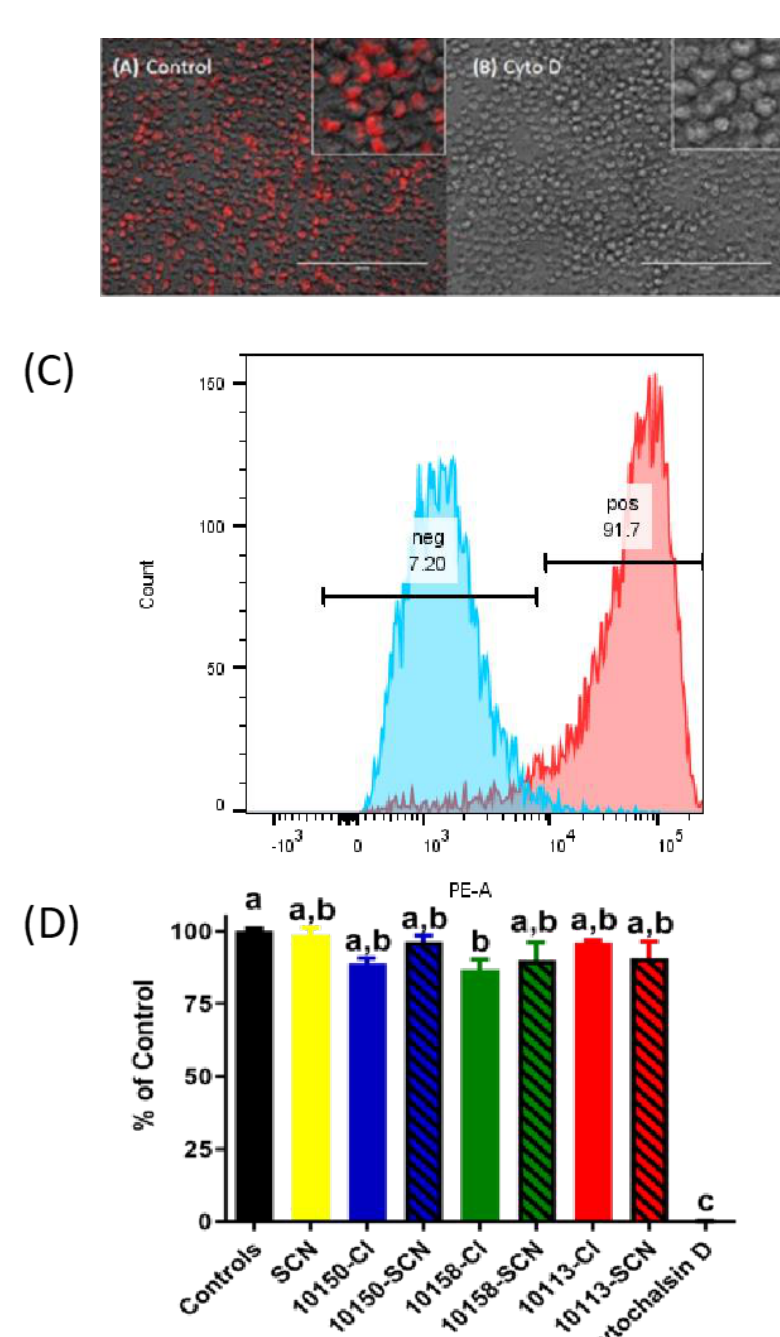
Figure 9. Meso -porphyrin formulation does not interfere with phagocytosis . Mouse macrophage cells (J774A.1) were treated for 1 h with either 400 µ M thiocyanate (SCN) or 100 µ M of manganese meso -porphyrins (MnP) in either their chloride (Cl, solid bars) or thiocyanate (SCN, hatched bars) formulations in a cell-imaging buffer containing Staphylococcus aureus bioparticles labeled with pH- sensitive red fluoroprobe. The fluorescence intensity was normalized to the fluoroprobe in an imaging buffer as 100%, and the cells were treated with 40 µ g/ml of cytochalasin D to inhibit the phagocytosis of the fluoroprobe as 0%. ( A ) Representative micrograph of 100% phagocytosis, and ( B ) representative micrograph of 0% phagocytosis; magnification bar is 400 µ m. ( C ) A flow cytometry histogram was used to quantitate phagocytosis based on the control and cytochalasin D (40 µ g/ml) positive staining cells. ( D ) Cells were gated on side scatter and PE (red) signals. Different letters indicate a significant difference between treatment groups; p < 0.05.